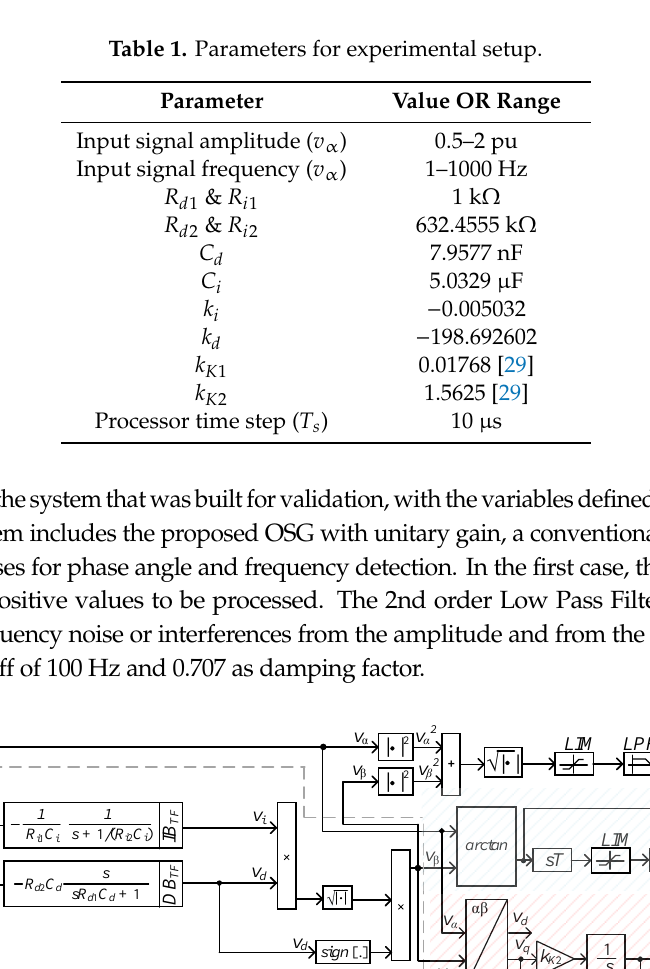
Table 1. Parameters for experimental setup.